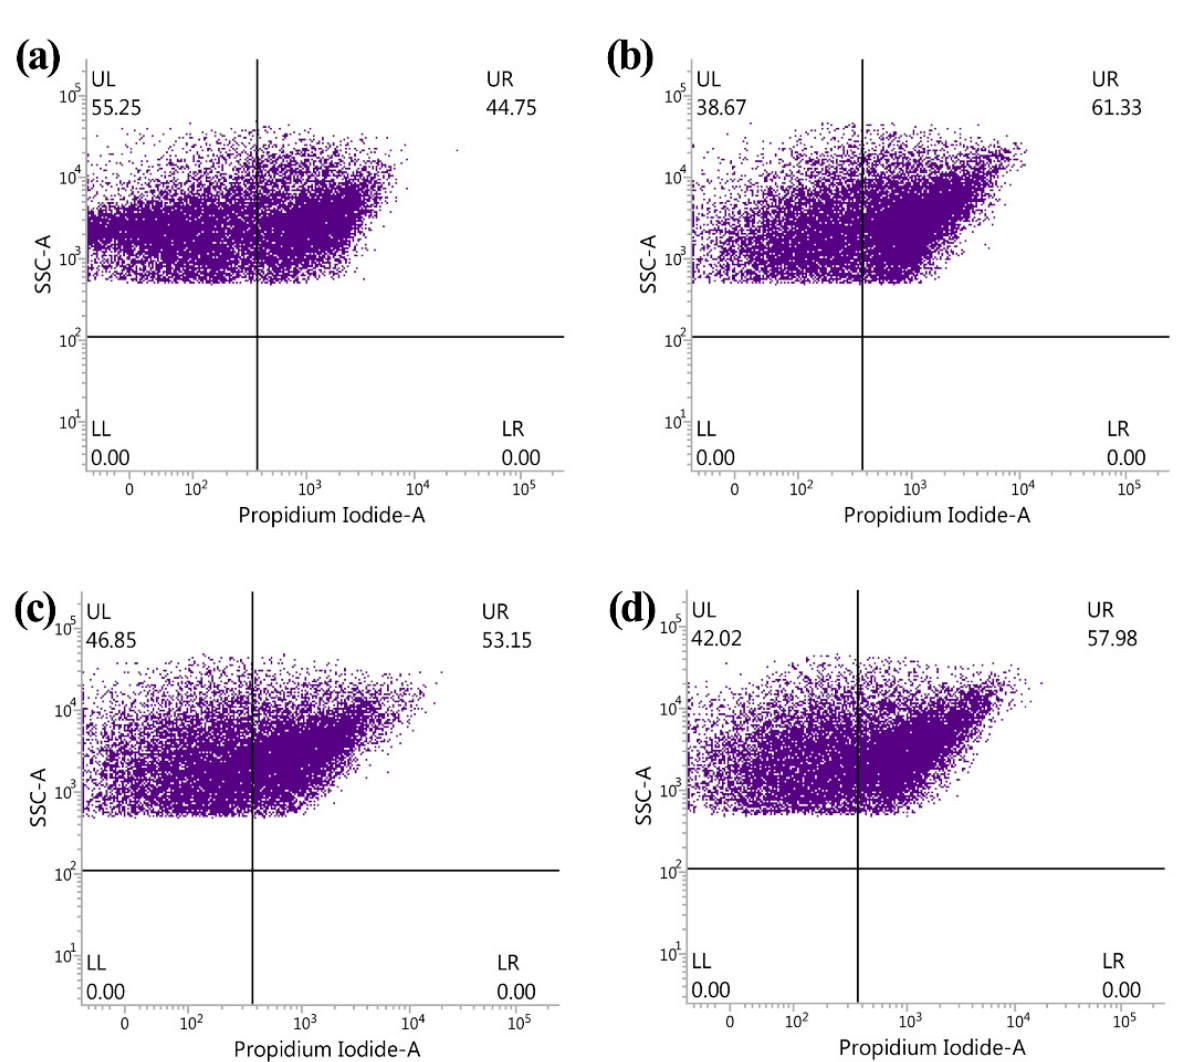
Figure 3. Antibacterial effect of ZnONP on gut bacteria from healthy and ASD children by flow cytometry observation: ( a ) healthy; ( b ) healthy + ZnONP; ( c ) ASD; ( d ) ASD + ZnONP.